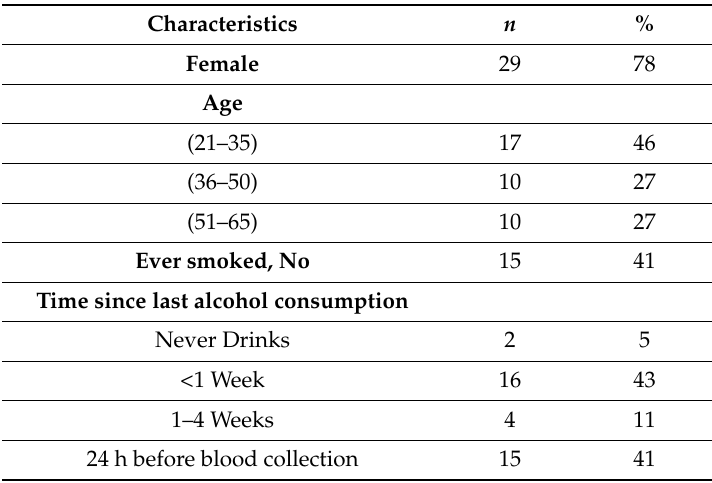
Table 1. Characteristics of study participants ( N = 37) who contributed to at least one pair of exposure-outcome analysis. Age was collected in